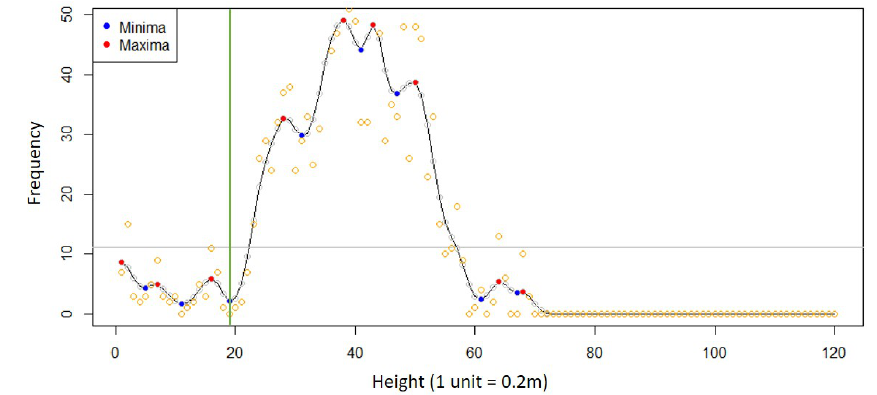
Figure 5. A vertical point frequency distribution (orange points) graph of one bin (i.e., voxels over a 10 m resolution cell). X axis is the point frequency of the voxels and Y axis is the vertical order of the voxels starting from the ground (i.e., voxel with value 1 presents the point frequency between 0–0.2 m height etc.). The points in grey color connected by the black line represent the smoothed frequency values. Blue and red colored points refer to the detected local minima and maxima respectively. The horizontal grey line stands for the average point frequency of the entire bin and the vertical green line shows the estimated CBH (i.e., the height of the voxel, the point frequency of which is the local minima before the first significant local